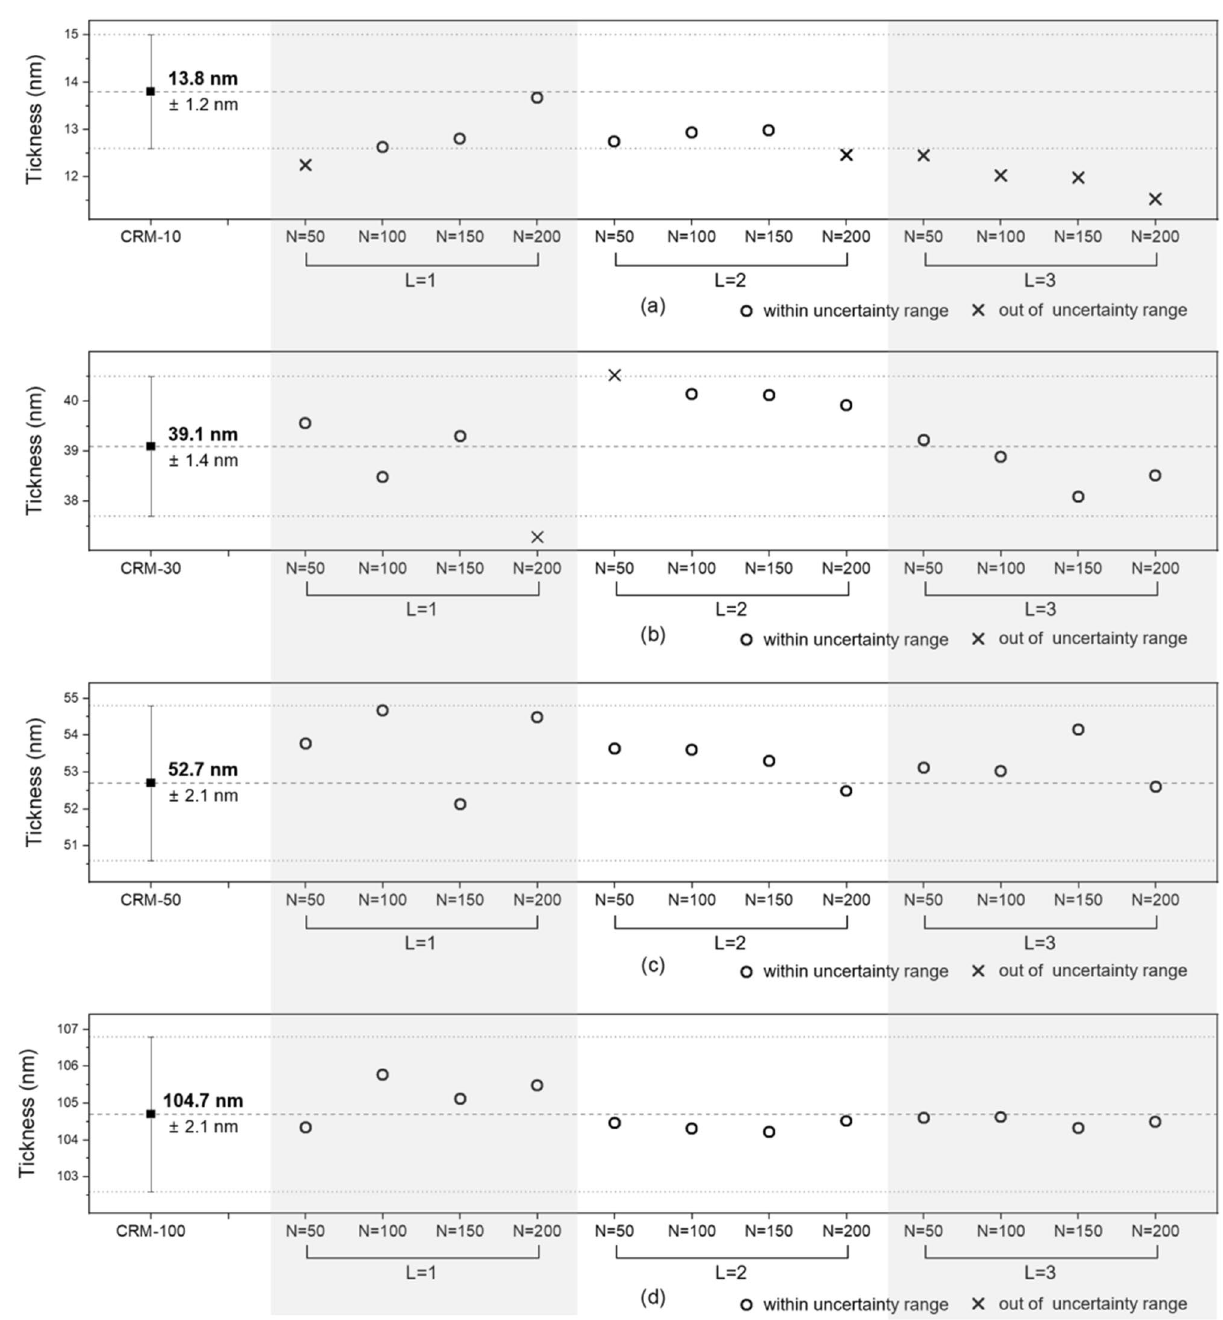
Figure 3. Analyzed thickness values of trained ANN algorithms for ( a ) CRM-10, ( b ) CRM-30, ( c ) CRM-50, ( d )